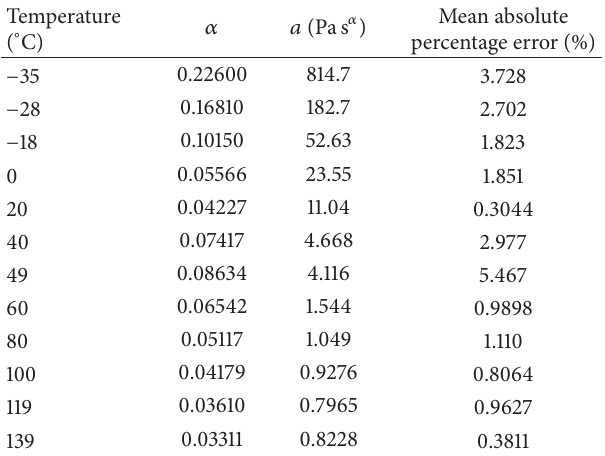
Table 1: Identified parameters of the proposed rheological model based on fractional calculus used to fit experimental uniaxial relaxation tests at different temperatures.